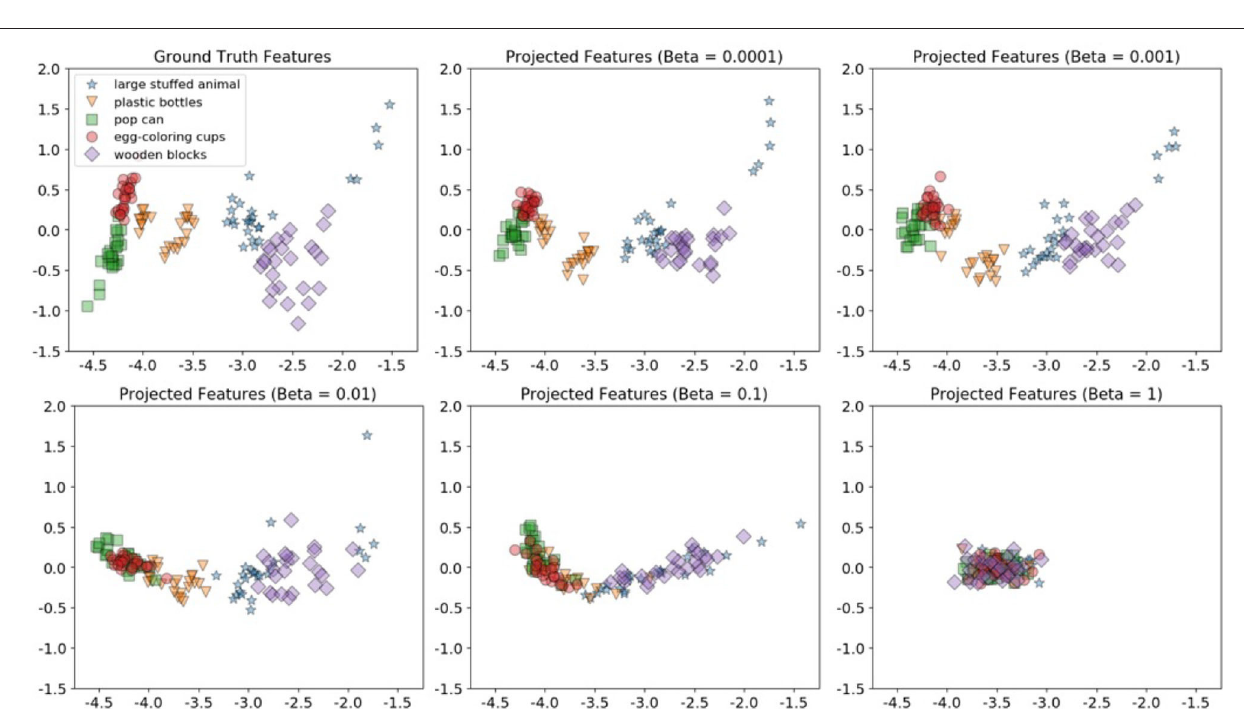
poke-haptic achieves 30.2%, and projecting press-haptic alone